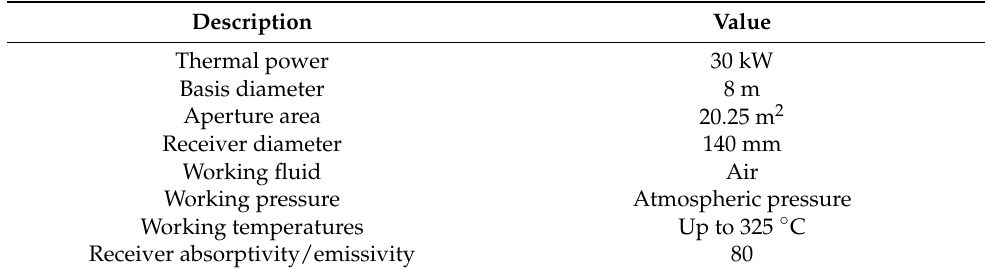
Table 1. Sundial prototype main